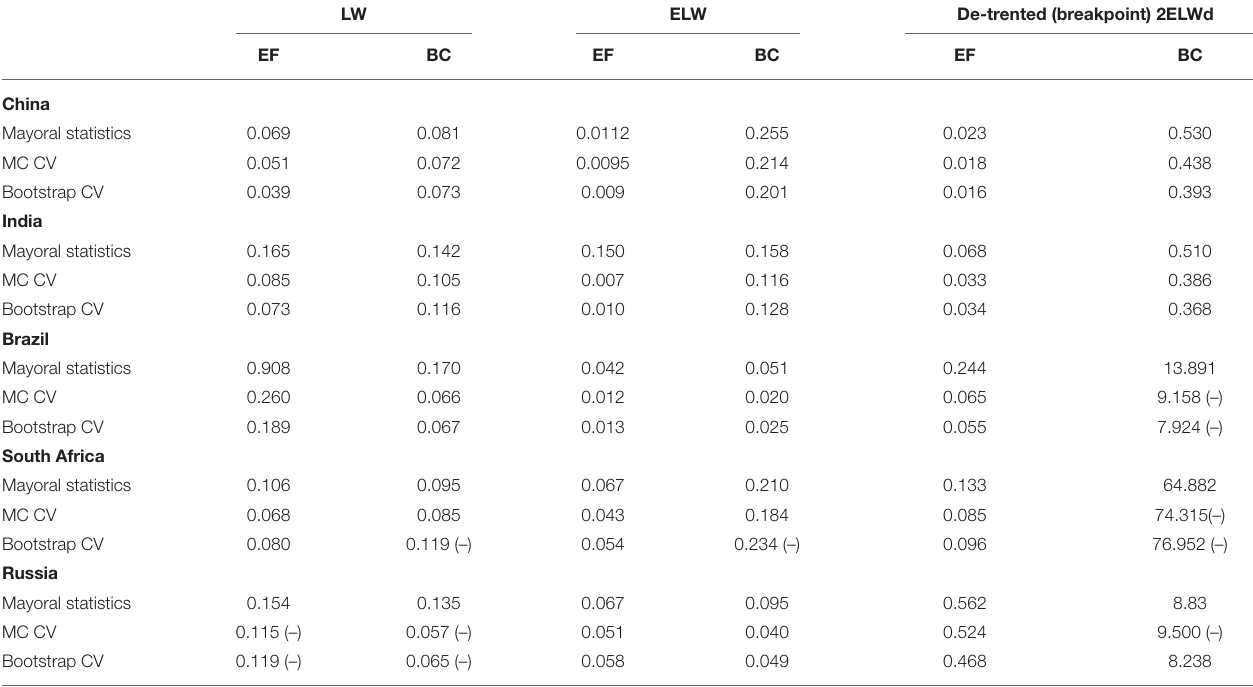
TABLE 4 | Pseudo-long memory Mayoral test of relative per capita environmental indicators in